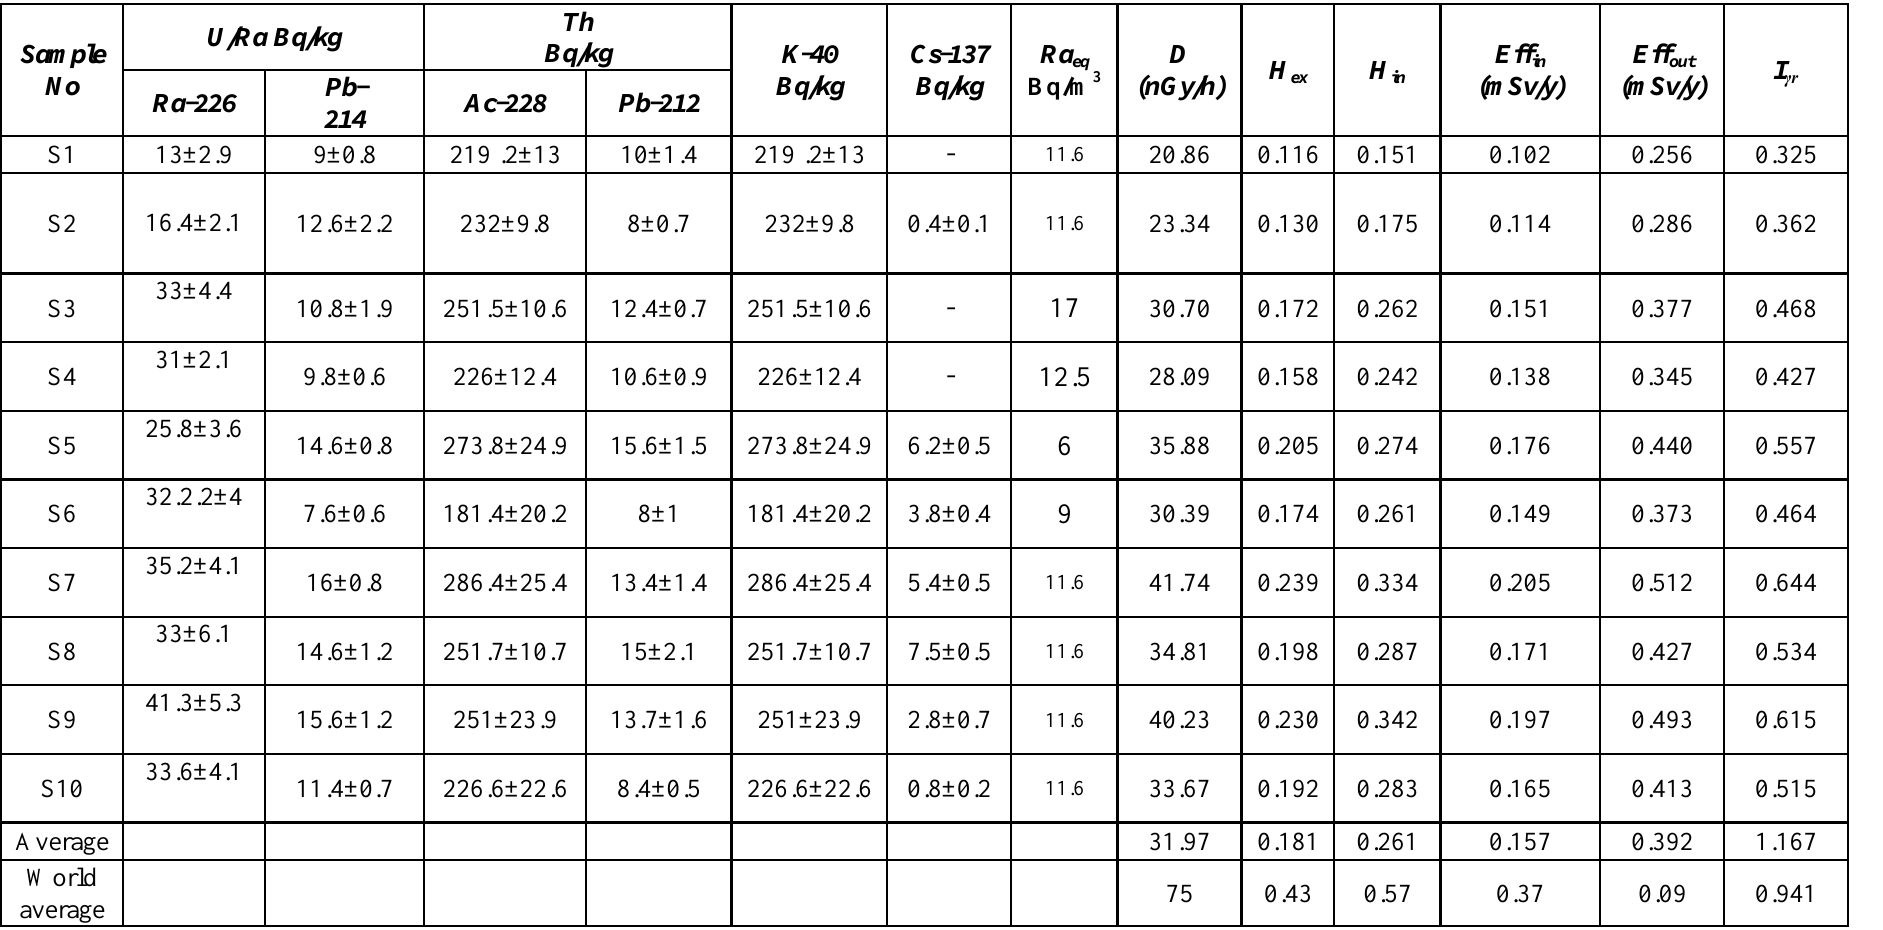
Table 2: Results data of radiological testing for soil